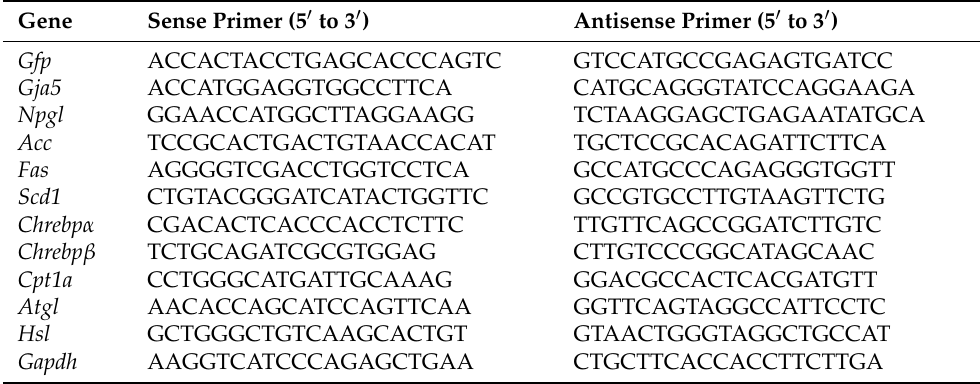
Table 2. Sequences of oligonucleotide primers for qRT-PCR.